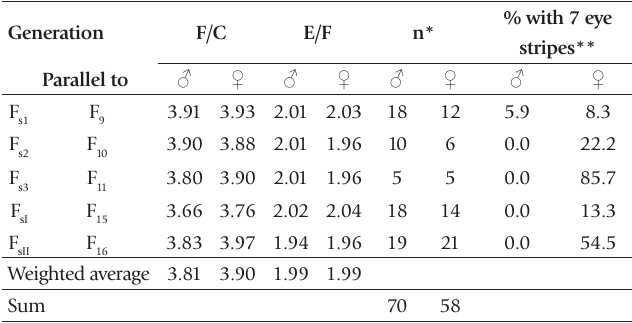
Table 4. Morphometrics of isolated Schistocerca gregaria , albino strain.